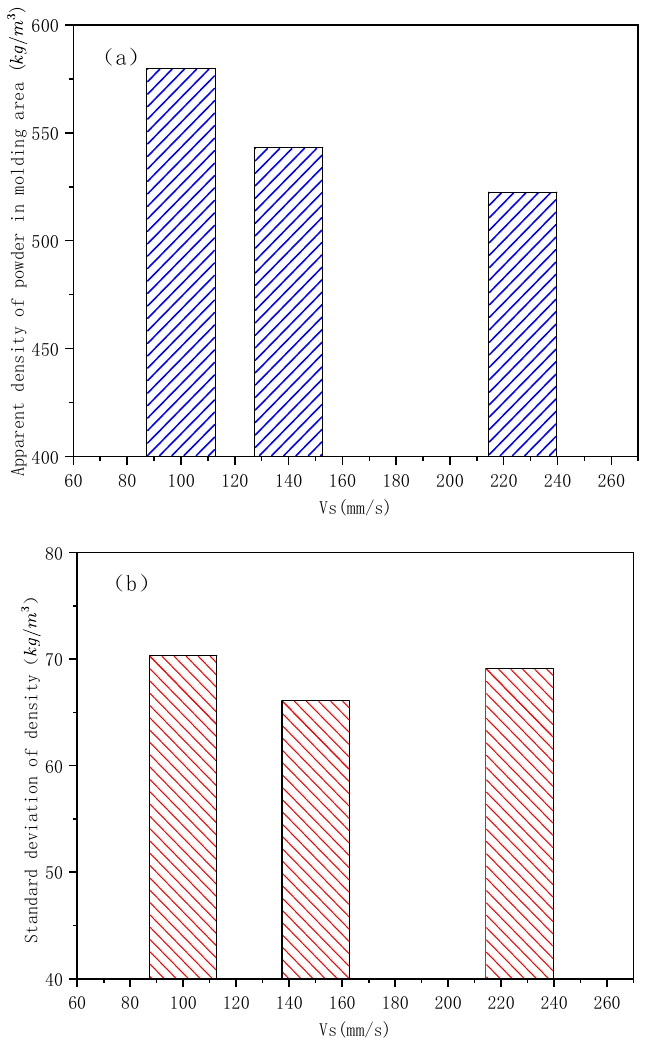
Figure 10. Experimental results of the powder spreading quality in the formation area ( V r / V s = 0.5, R g = 20 mm, D50 = 50 µ m): ( a ) effect of V s on the apparent density of powder in the formation zone; ( b ) effect of V s on the standard deviation of the formation zone density.